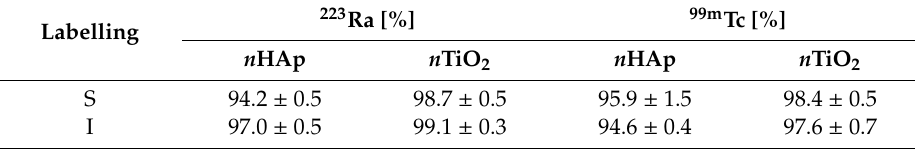
Table 2. Yields for 223 Ra and 99m Tc labelling of n HAp and n TiO 2 ( n =